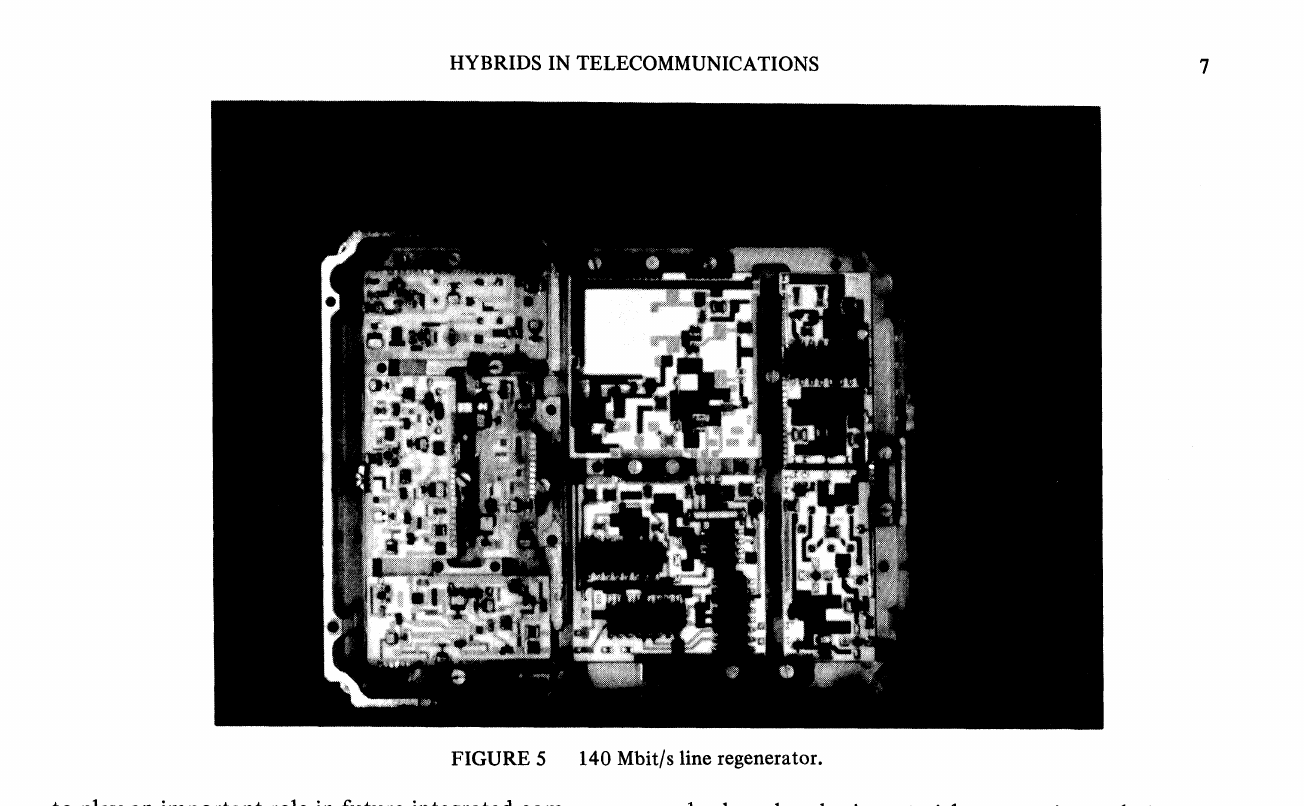
FIGURE 5 140 Mbit/s line